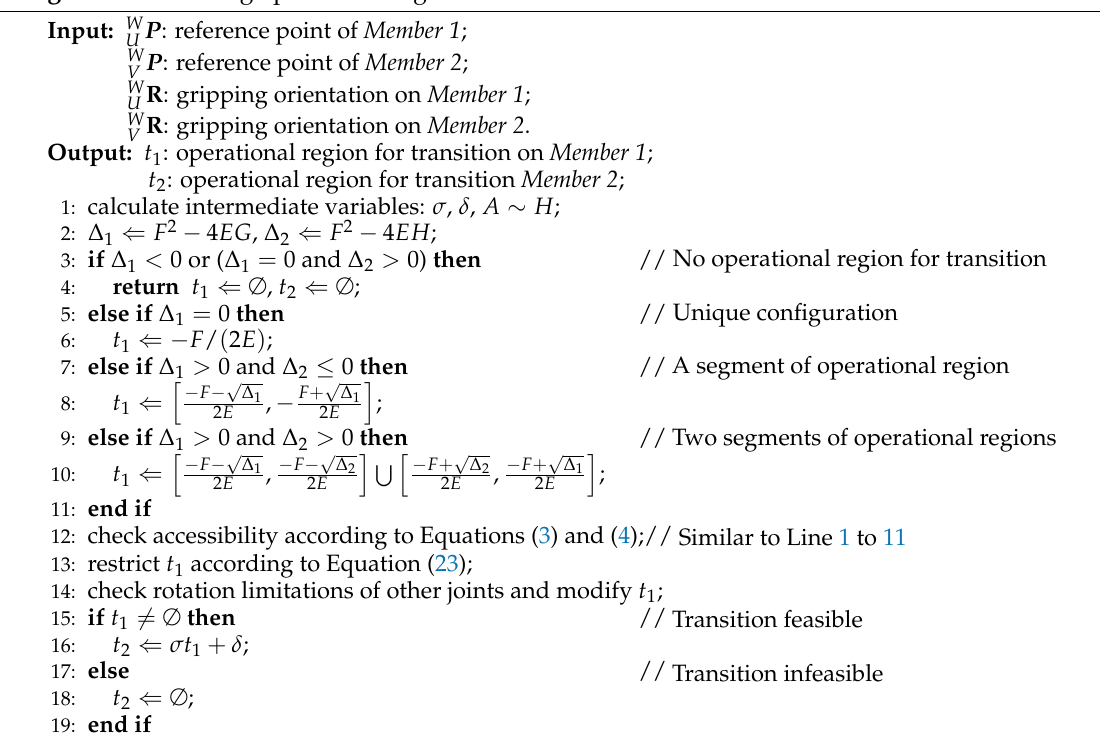
Algorithm 4: Solving operational regions for